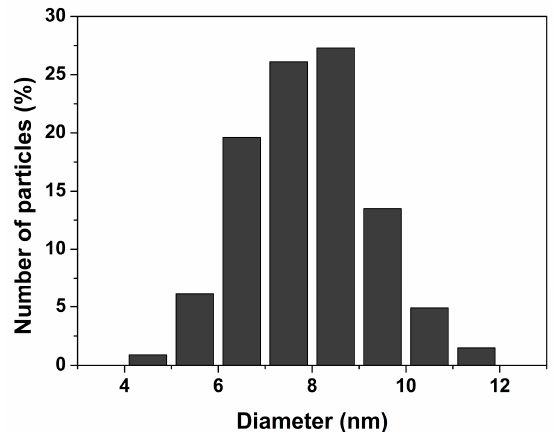
Figure 2. The TEM image and the size distribution histogram of 3 mol% Tb-doped CaF 2 nanoparticles.